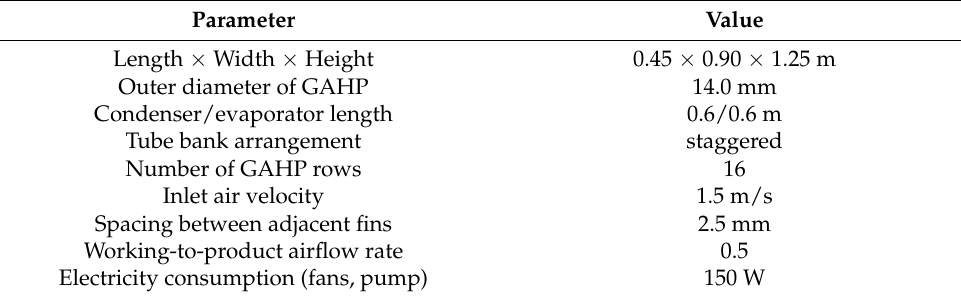
Table 2. Main design parameters of the GAHP-based IEC.